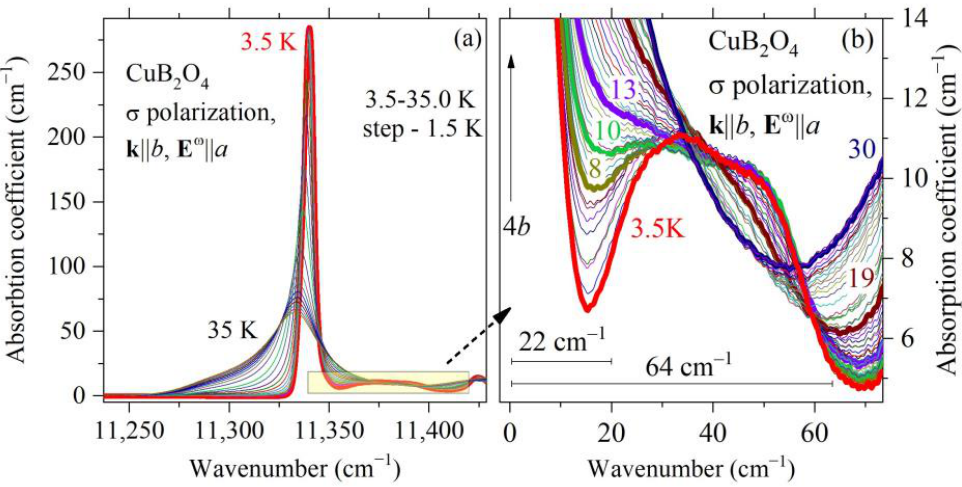
Figure 4. Temperature dependence of ( a ) the lowest-frequency ZP exciton line and ( b ) its nearest higher-frequency broad magnon satellite.